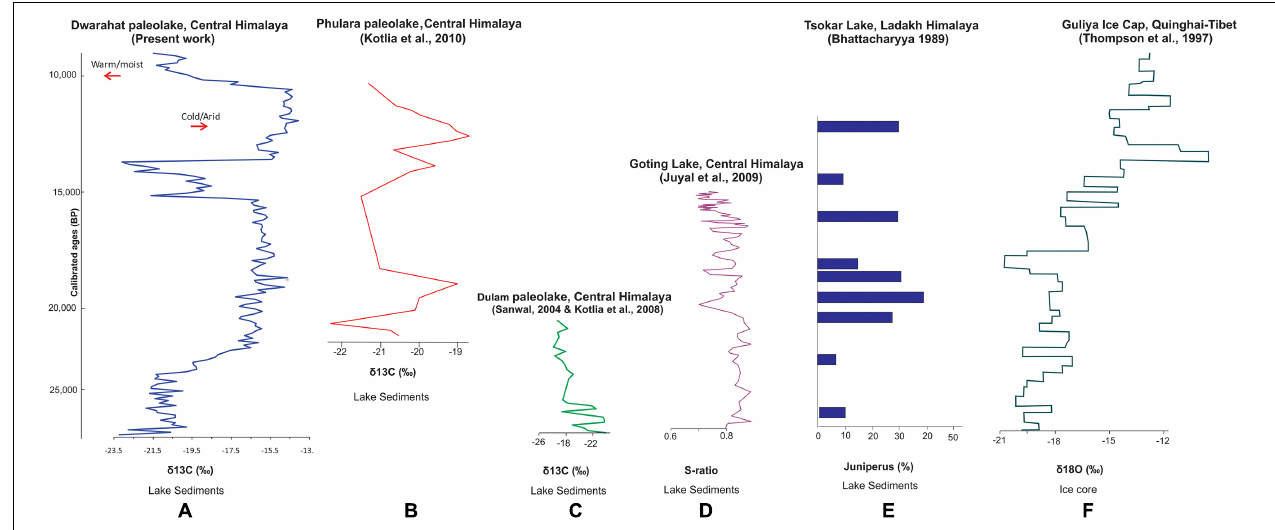
FIGURE 4 | A few proxy records of paleoclimate covering the last glacial-interglacial transition, reconstructed from the Central Himalaya (A–D) Ladakh Himalaya (E) and Guliya Ice Cap, Qinghai-Tibet (F) .